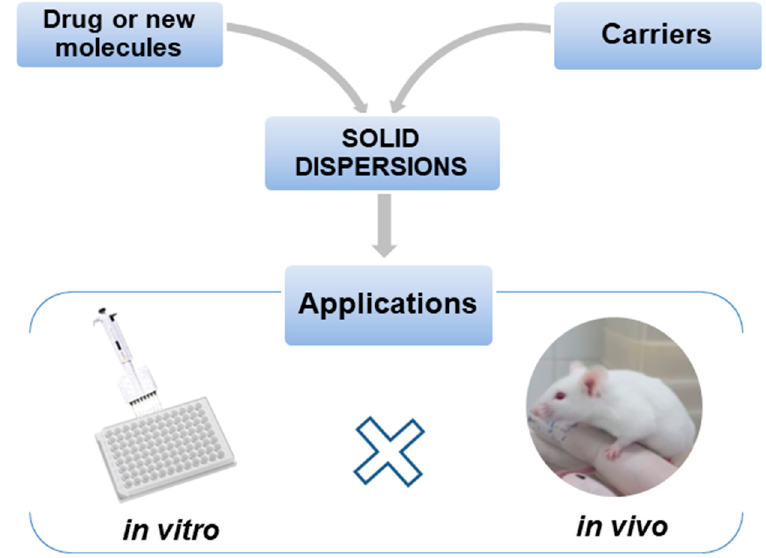
Figure 1. Representation of the application of solid dispersions in biological assays.